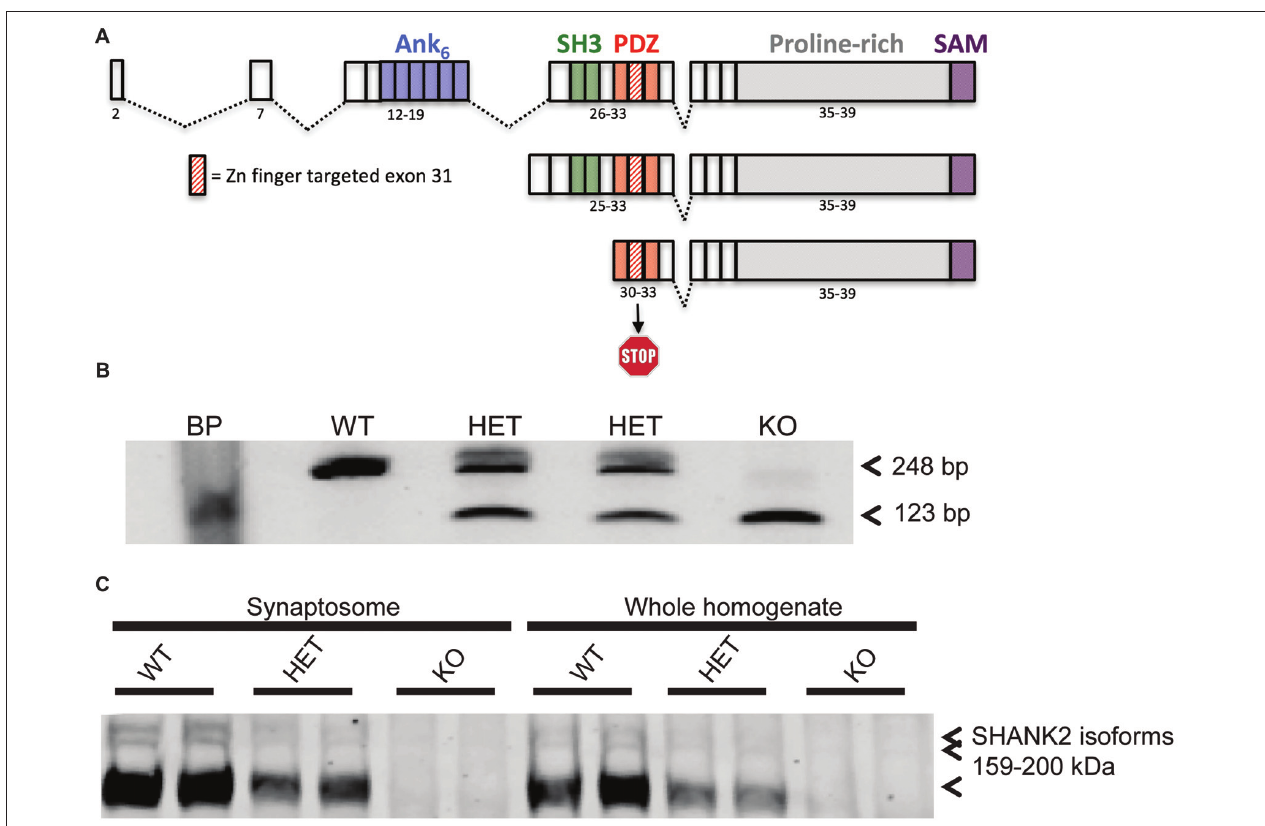
FIGURE 1 | Generation of the Shank2 mutant rat. (A) 437 bp genomic DNA (gDNA) deletion, encompassing exon 31 in the PDZ domain of the rat Shank2 gene, results in a frameshift mutation and premature stop codon in the resultant mRNA transcript. (B) RT-PCR analysis of WT, HET and KO rat Shank2 mRNA around exon 31. Arrows indicate the WT (upper–248 bp) and KO (lower–123 bp) expected PCR products in the resultant Zn-finger KO mRNA. (C) No detectable expression of any of the three variants of full length SHANK2 protein product is detected in the KO animals in either whole brain homogenate or enriched synaptosomal fractions (see entire western blot in Supplementary Figure S1B ).